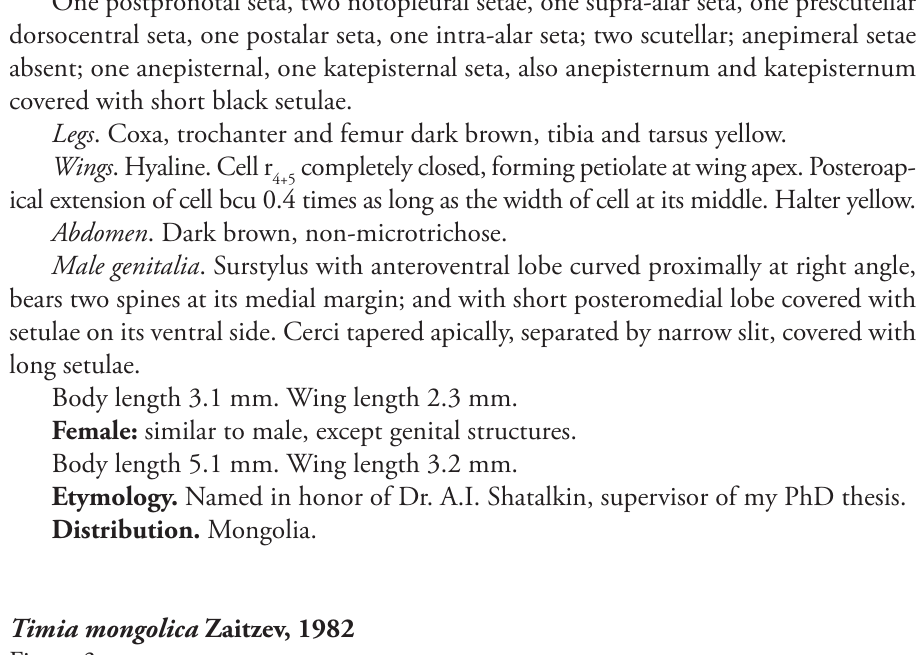
Type material. Holotype male: Mongolia: “ Монголия, Баян-Хонгорский аймак, 30 км ССВ родн. Шара-Хулсны-Булак, Зайцев , 4.IX.1970” Bayankhongor Province, 30 km NNE spring Shara Hulsny-Bulak, 4.IX.1970, Zaitzev leg. (ZISP). Paratype: Mongolia: 1 male, label as in the holotype (ZISP). Additional material: Mongolia: 3 males, 1 female, label as in the holotype (ZISP). Redescription. Male: Head . Frons yellow, with large black triangle medially, without microtri- chosity, evenly covered with short and thin black setulae. Ocellar triangle shining black. Lateral part of vertex entirely yellow without dark marks. Occiput yellow, medi- ally black, slightly microtrichose close to eye margin, covered with short and thin black setulae. Gena yellow, 0.4 times as low as eye. Postgena yellow. Parafacialium yellow, 0.5 times as narrow as antennal grooves and as wide as flagellomere 1. Eye 1.3 times as high as wide. Lunula yellow. Face yellow, without narrow darkened band along the ventral edge. Clypeus pale yellow, darkened along ventral edge. Scape and pedicel light brown. Flagellomere 1 brown at base, almost black at apex, matted. Arista light brown. Antennal groove yellow, with thin silver-white microtrichosity. Proboscis brown. Pal- pus brown at base, black at apex. Thorax . Yellow, with black pattern. Mesonotum with silver-white microtrichose medial stripe. Postpronotum with silver-white microtrichosity. Scutellum